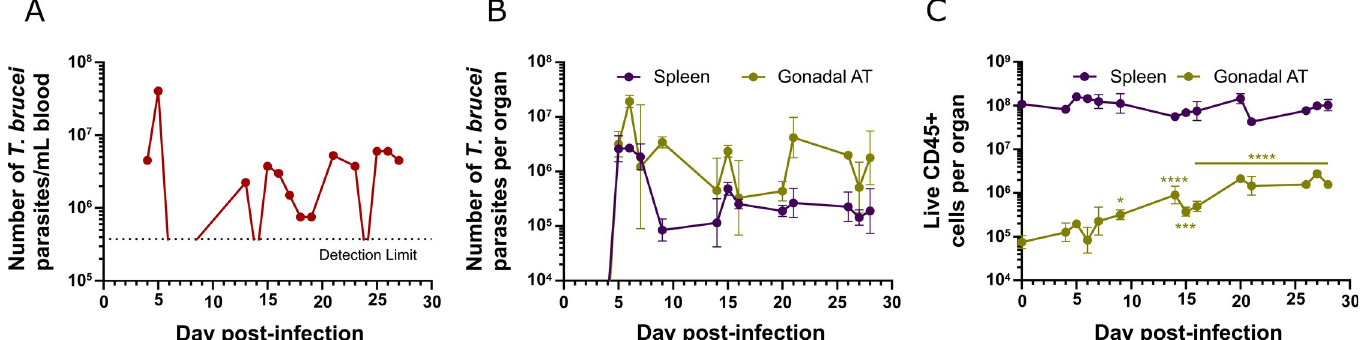
Fig 2. Dynamics of T . brucei parasites and immune cells throughout infection. (A) Number of T . brucei parasites per mL of blood of a single representative mouse, quantified using a hemocytometer. Dashed line represents the detection limit (3.75x10 5 parasites/mL of blood). (B) Total number of T . brucei parasites in the spleen and gonadal AT, quantified by qPCR. (C) Number of live immune cells in spleen and gonadal AT. (B-C) Error bars represent the standard error of the mean (SEM) (n = 2–6 mice per group). Statistical analysis was performed with a two-way analysis of variance (ANOVA) using Sidak’s test for multiple comparisons. � refers to statistical differences within the groups in each time-point and the non-infected group. � , P < 0.05; �� , P < 0.01; ��� , P < 0.001; ���� , P < 0.0001.